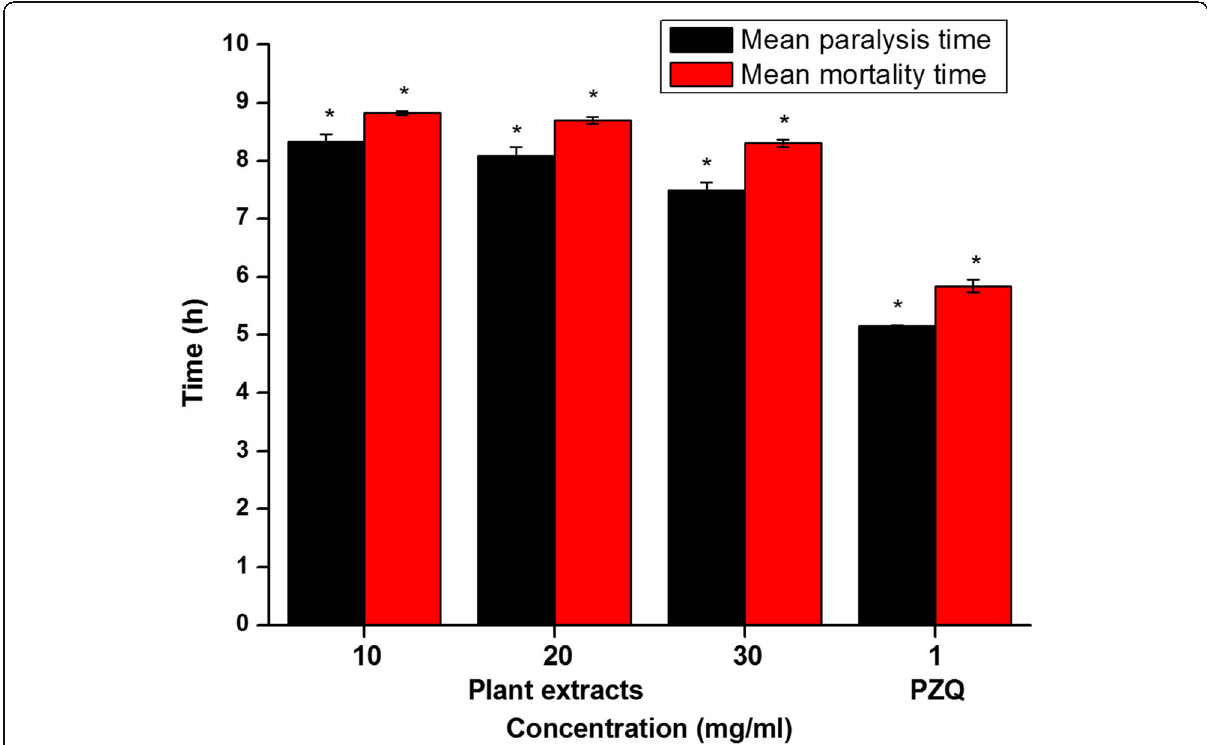
Fig. 2 In vitro anthelmintic efficacy of C. compressus methanolic root extract against H. diminuta . Data is expressed as mean ± SEM. * p < 0.0001 compared with control group, Students ’ t